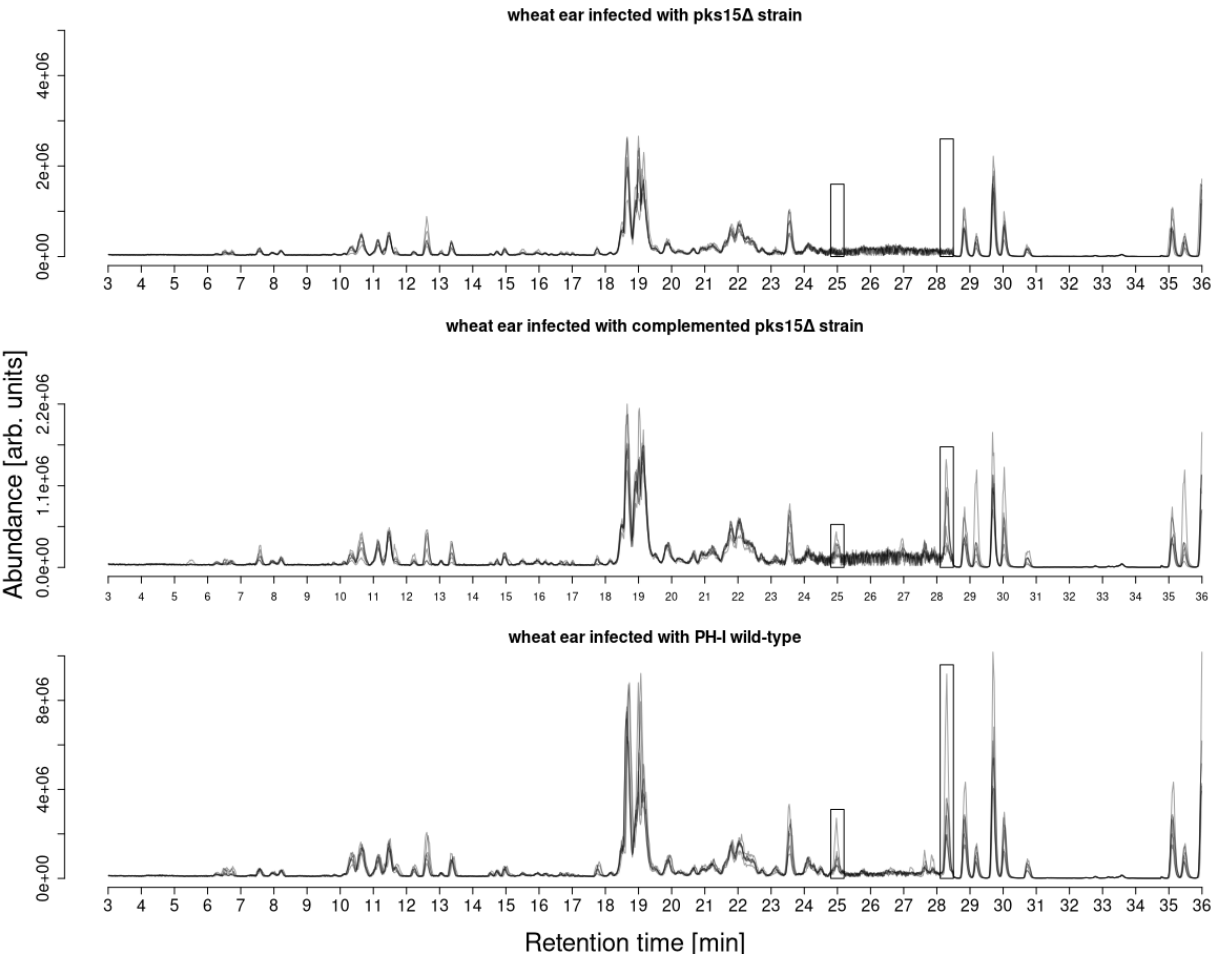
Figure 7. Comparison of basepeak chromatograms ( m / z range 500 – 550) of wheat ear extracts of Remus plants treated with F. graminearum complemented pks15Δ (upper panel), pks15Δ (middle panel) and PH-1 wild-type (lower panel) strains. Gramiketides A and B marked in boxes. Both gramiketides were found to be present in the complemented pks15 mutant and wild-type PH-1 treated wheat samples but missing in the pks15Δ treated samples.